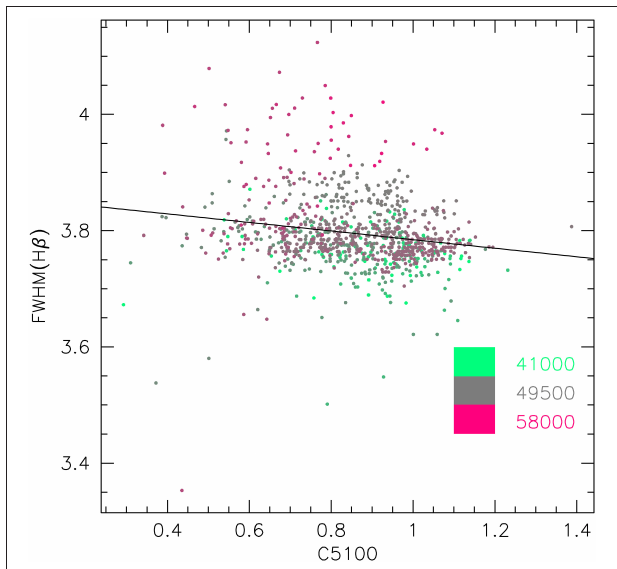
FIGURE 6 | Anti-correlation between FWHM of H β and continuum specific flux at 5100 Å. The line shows an unweighted least squares fit. Colors of data points are coded from green to magenta according to Julian date, from 2441000 to 2458000. is brighter. Without considering the measurement dispersion in FWHM the slope is right − 0.25, as predicted by the elementary consideration above in case of r ∝ L 1 / 2 , and therefore FWHM ∝ L − 1 / 4 , since r ∝ FWHM − 2